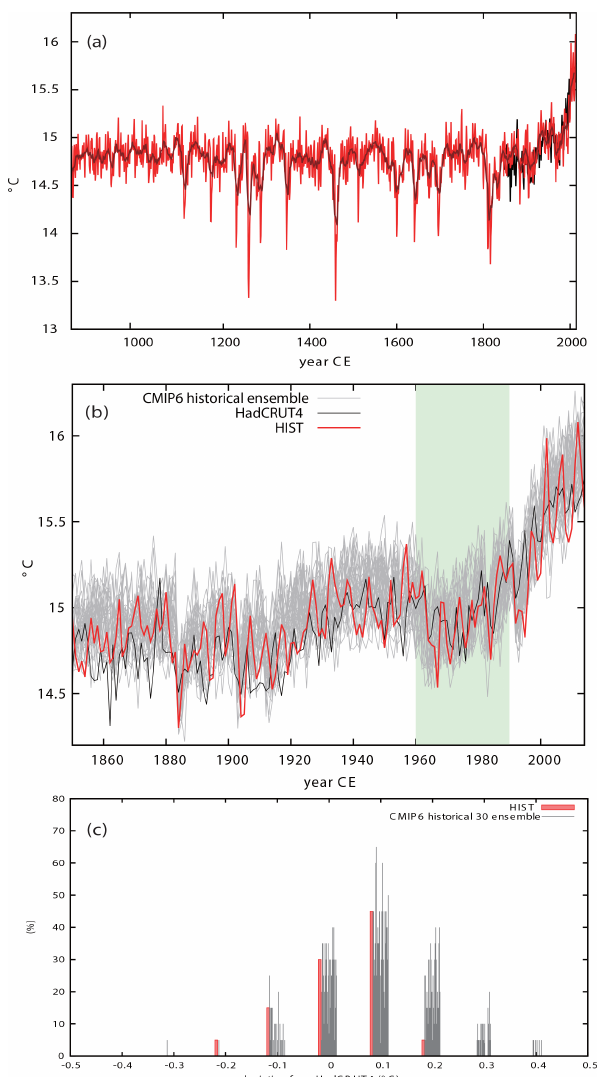
Figure 13. (a) Annual mean air temperature ( ◦ C) averaged over the Northern Hemisphere from the LM and HIST experiments (red: an- nual mean; dark red: 10-year running mean) and observational data from HadCRUT4 (black). (b) Annual mean air temperature ( ◦ C) averaged over the Northern Hemisphere from 1850–2014 for HIST and 30 ensemble members of the historical experiments (gray) and HadCRUT4 (black). HadCRUT4 is scaled for the period from 1961–1990 (period shaded light green). (c) Histogram of deviations from HadCRUT4 shown in panel (b) , averaged for every 5-year mean during 1850–1949, counted in 0.1 ◦ C increments in bins. Red: HIST experiment; gray: CMIP6 historical ensemble of 30